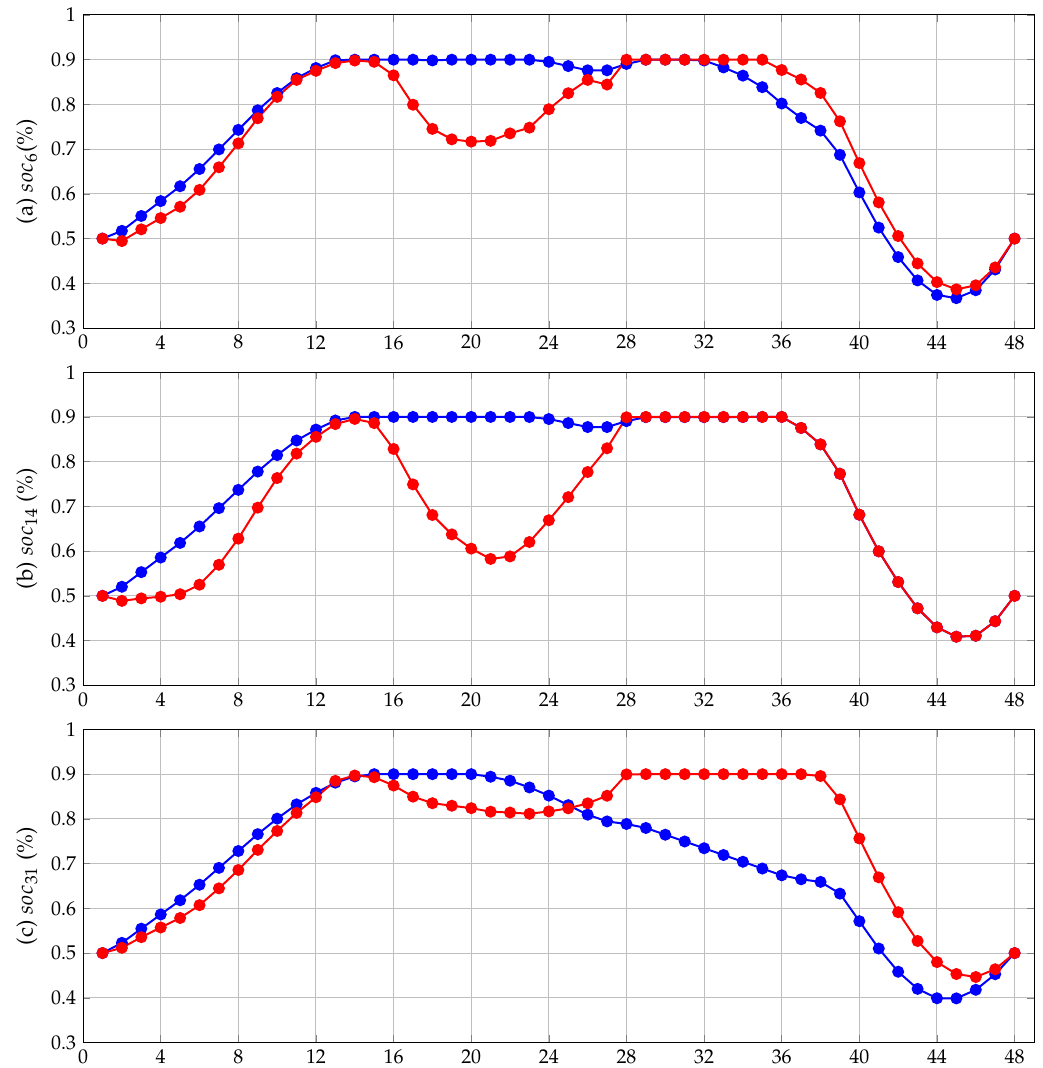
Figure 5. Behavior in the states of charge with the unity power factor simulation